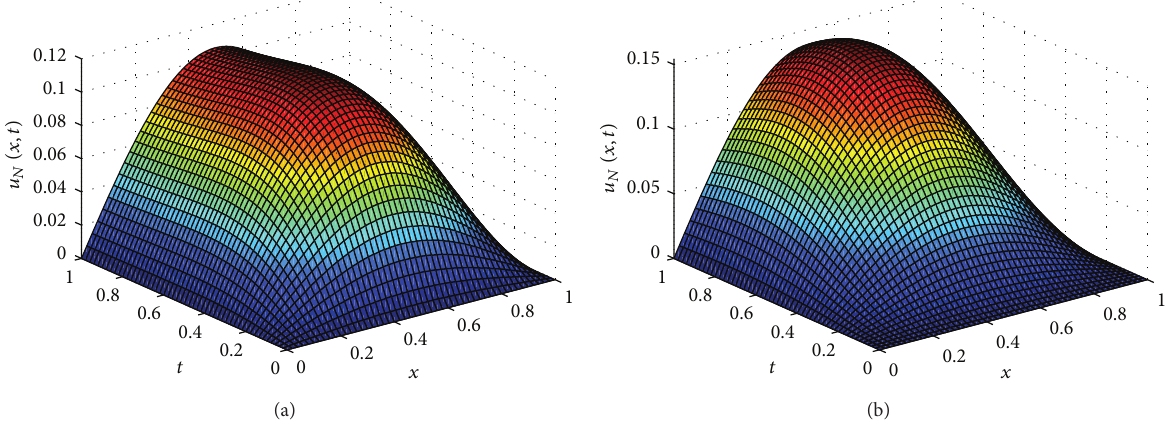
Figure 1: The numerical solutions with 𝛼 = 1.3 (a) and 𝛼 = 1.7 (b).